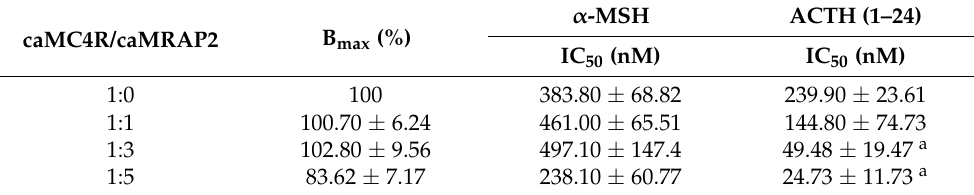
Table 3. The effect of caMRAP2 on ligand binding properties of caMC4R.